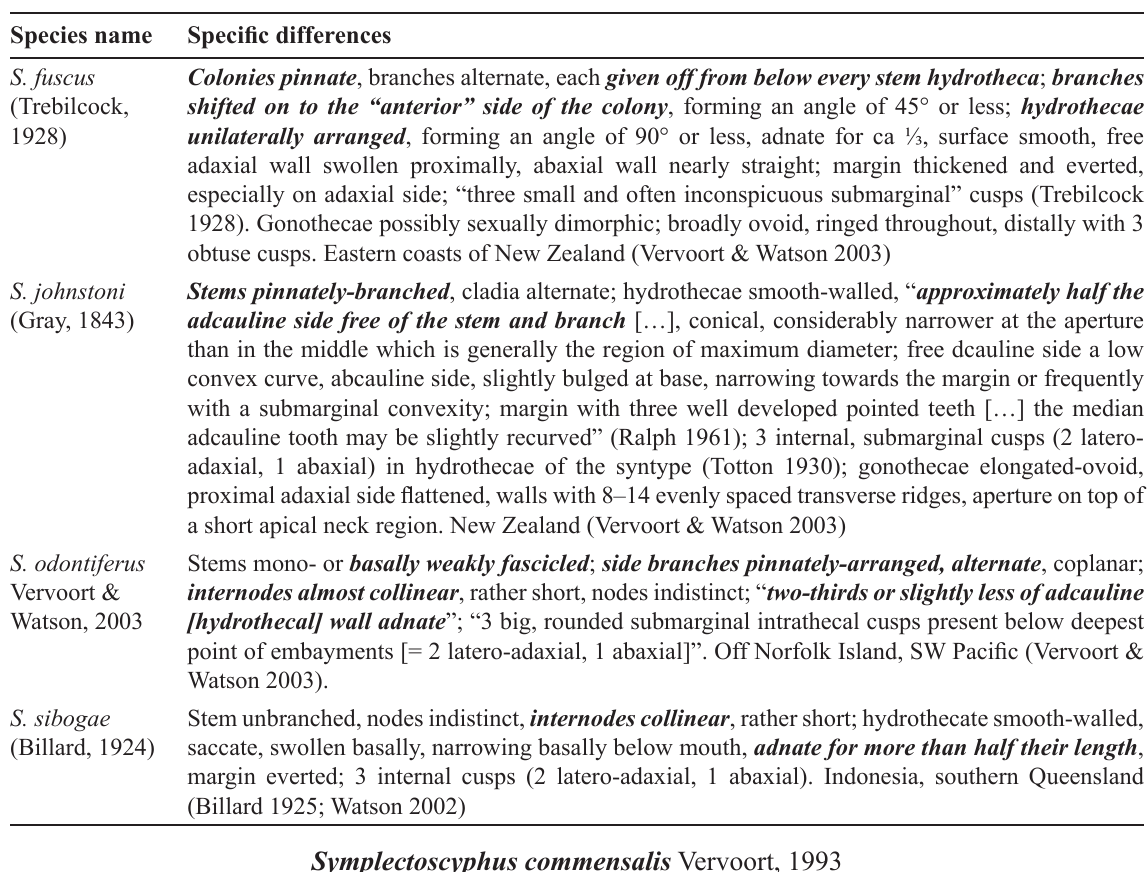
Table 10. Species of Symplectoscyphus with submarginal, intra-hydrothecal cusps, and their differences to S. acutustriatus Galea, sp. nov. and S. elongatulus Galea, sp. nov. N.B.: To these should be added S. indivisus (Bale, 1882), S. macrothecus (Bale, 1882) and S. neglectus (Thompson, 1879) dealt with in Table